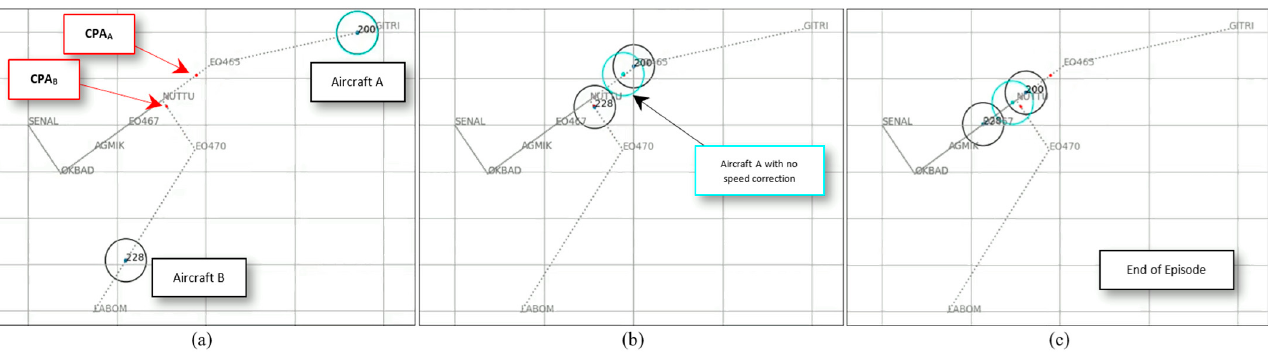
Figure 7. Admissible paths (in blue) from the end of CORSI-EO462 leg to SENAL (FAF). The mentioned STAR procedure is also characterized by upper speed limits ranging from 210 to 230 kts (imposed by the next waypoints). The horizontal and vertical separation minima are assumed to be 5 NM (equal for the longitudinal and lateral 8.8